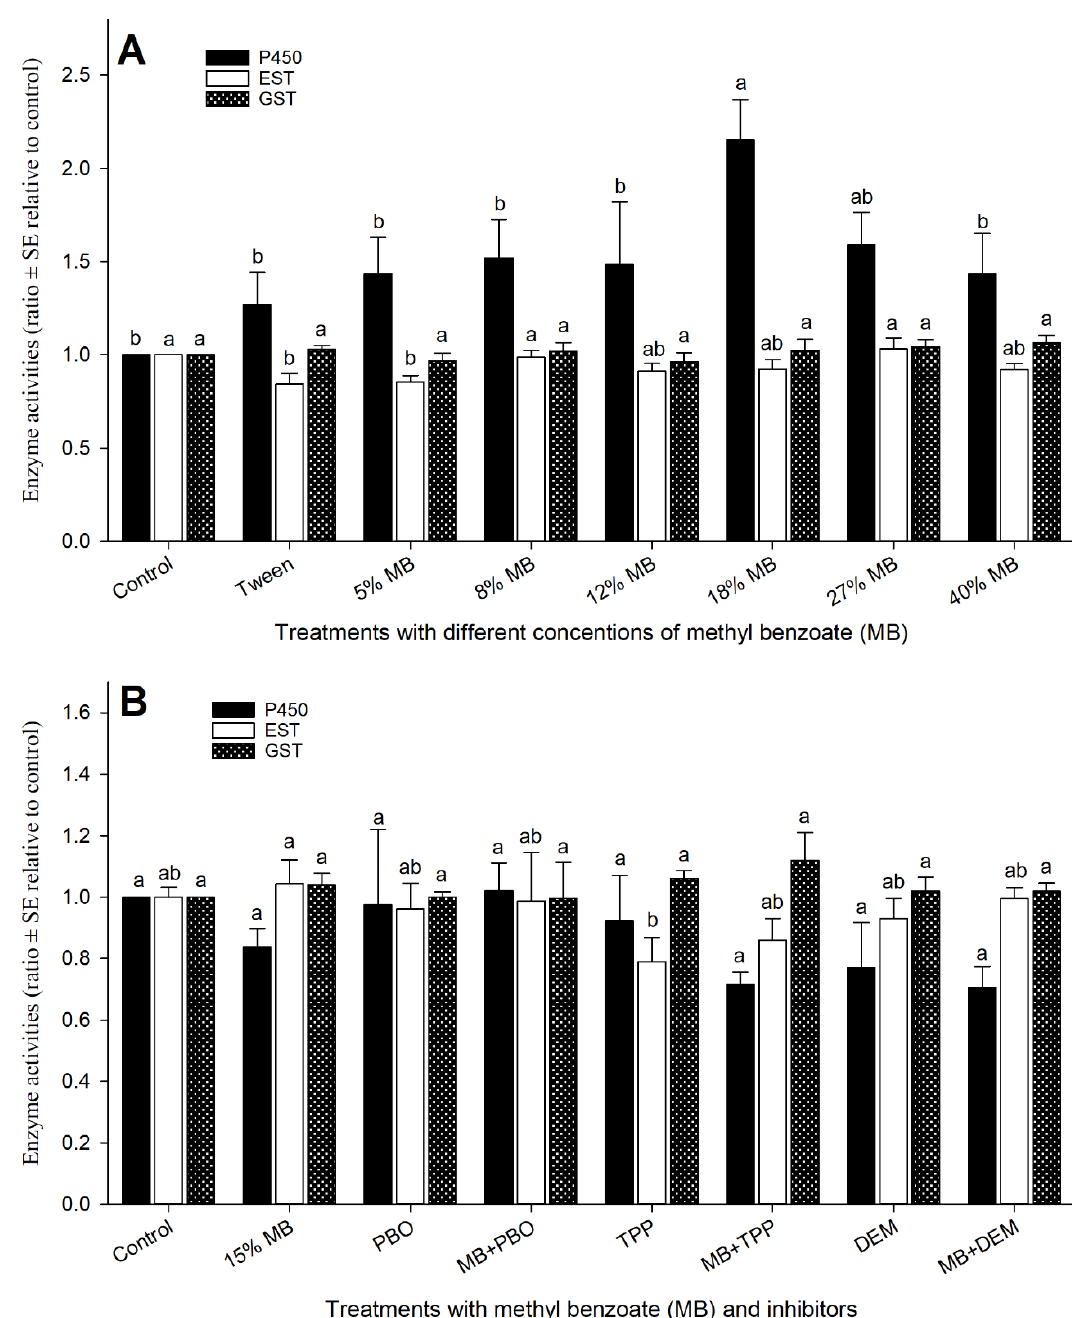
Figure 6. Impact of methyl benzoate (MB) on three detoxification enzymes in honey bee survivals after treatments with six different concentrations of MB ( A ) and detoxification enzyme inhibitors ( B ). Mean bars with the same letters at the top of error bars indicate no significant difference between treatments ( p > 0.05) within enzyme group. PBO: Piperonyl butoxide which inhibits P450 oxidase (P450); TPP: Triphenyl phosphate which inhibits esterase (EST); and DEM: Diethyl maleate which inhibits glutathione S-transferase (GST).